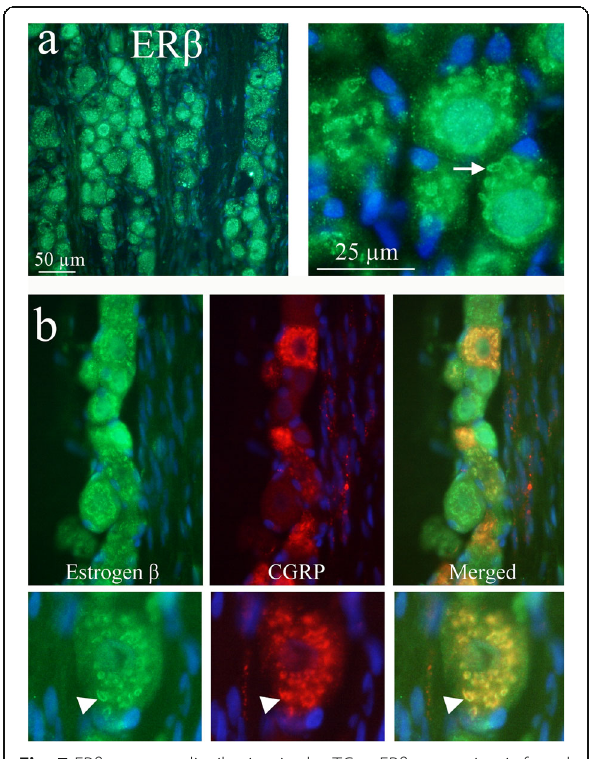
Fig. 7 ER β receptor distribution in the TG. a ER β expression is found in the cytoplasm of most neurons. In the higher magnification to the right, arrow points at an ER β immunoreactive neuron. b Double immunohistochemistry with ER β and CGRP antibodies revealed in higher magnification that both ER β and CGRP expression is found in the same organelle, possibly the Golgi apparatus (arrow